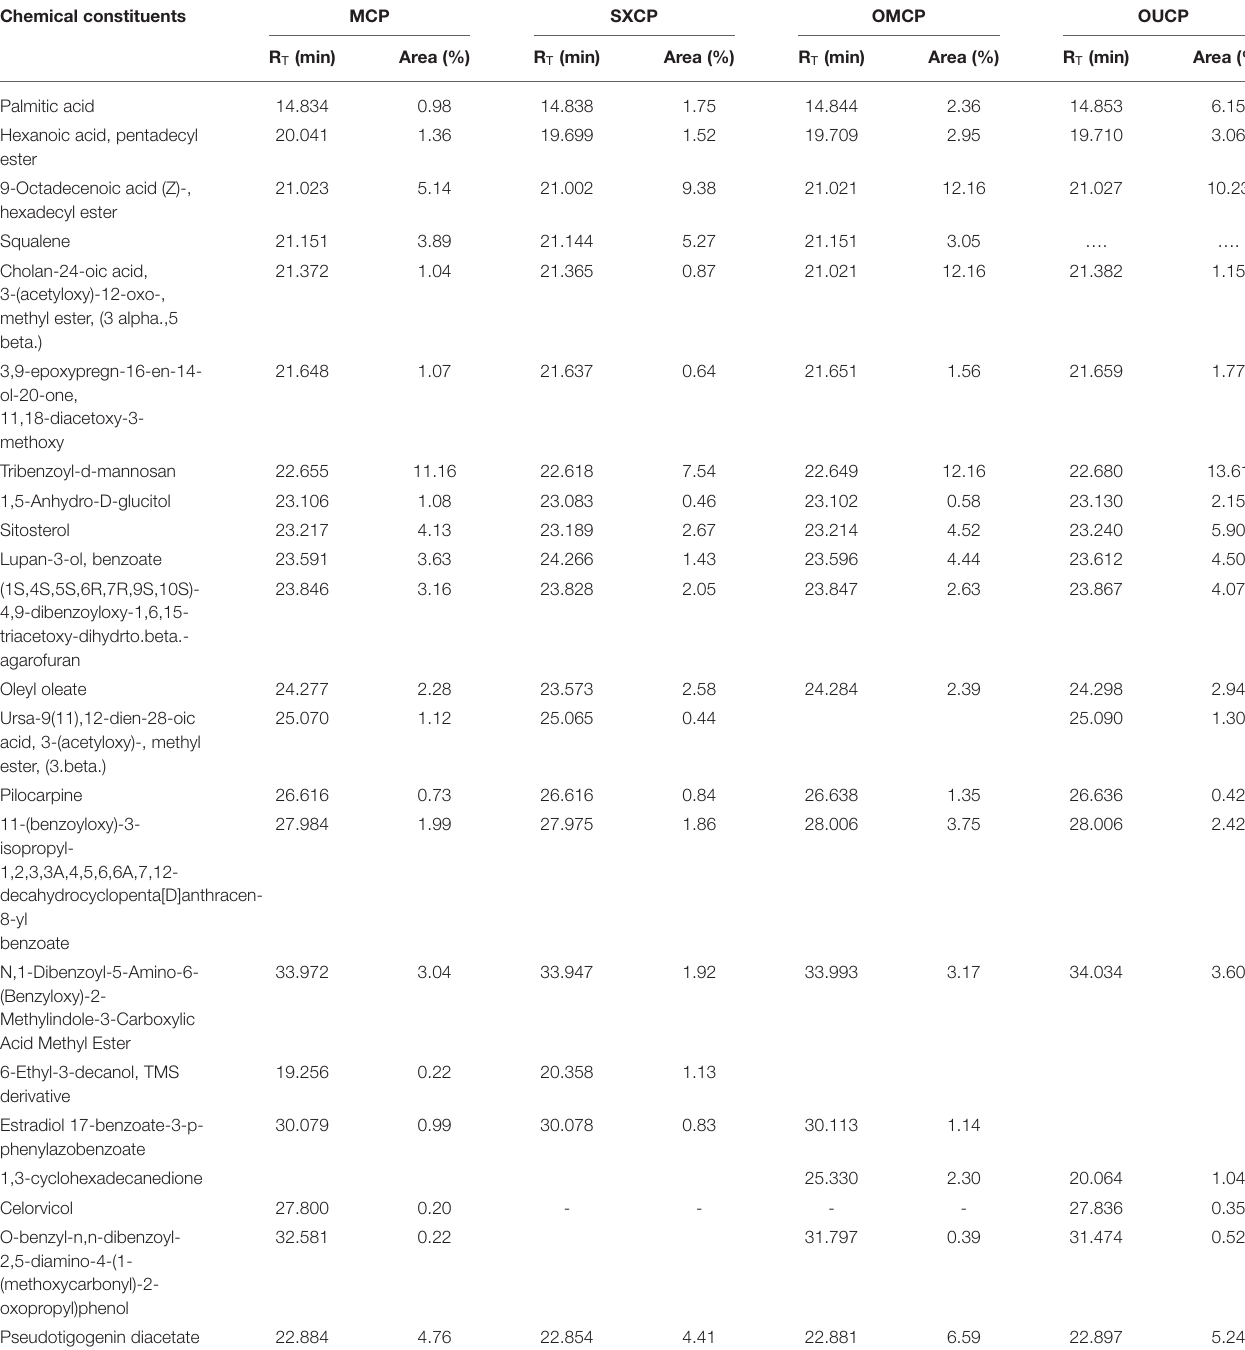
TABLE 4 | Possible constituents reported in different extracts of CP Willd by GC-MS analysis. Chemical constituents MCP SXCP OMCP OUCP